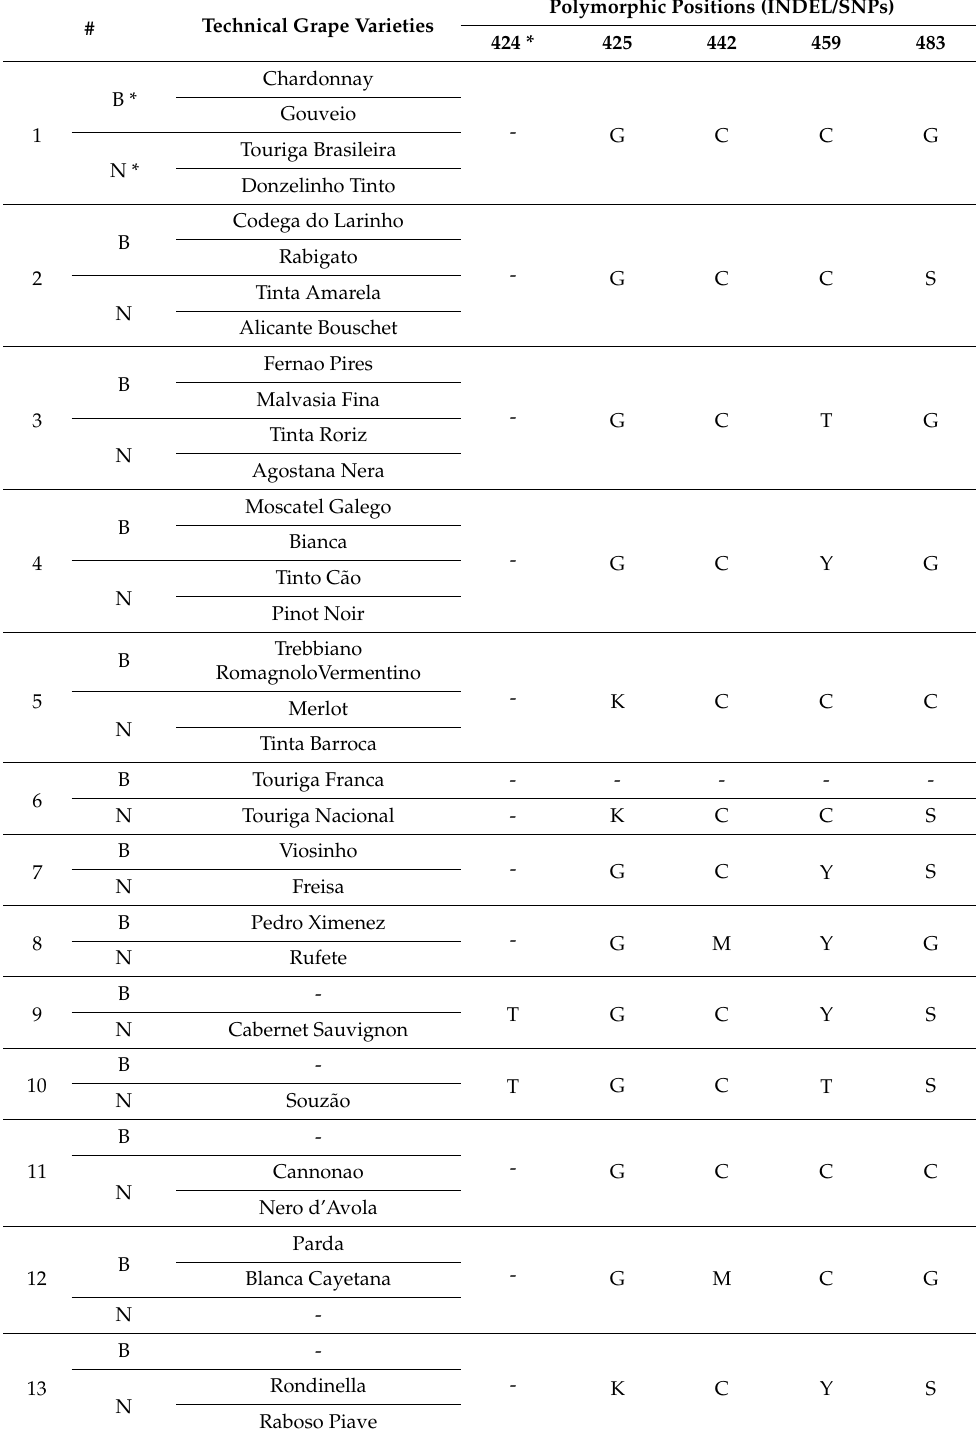
* B—blanc (white color of grape berry), N—noir (black color of grape berry), INDEL (424 nt). # index number of UFGT gene-associated